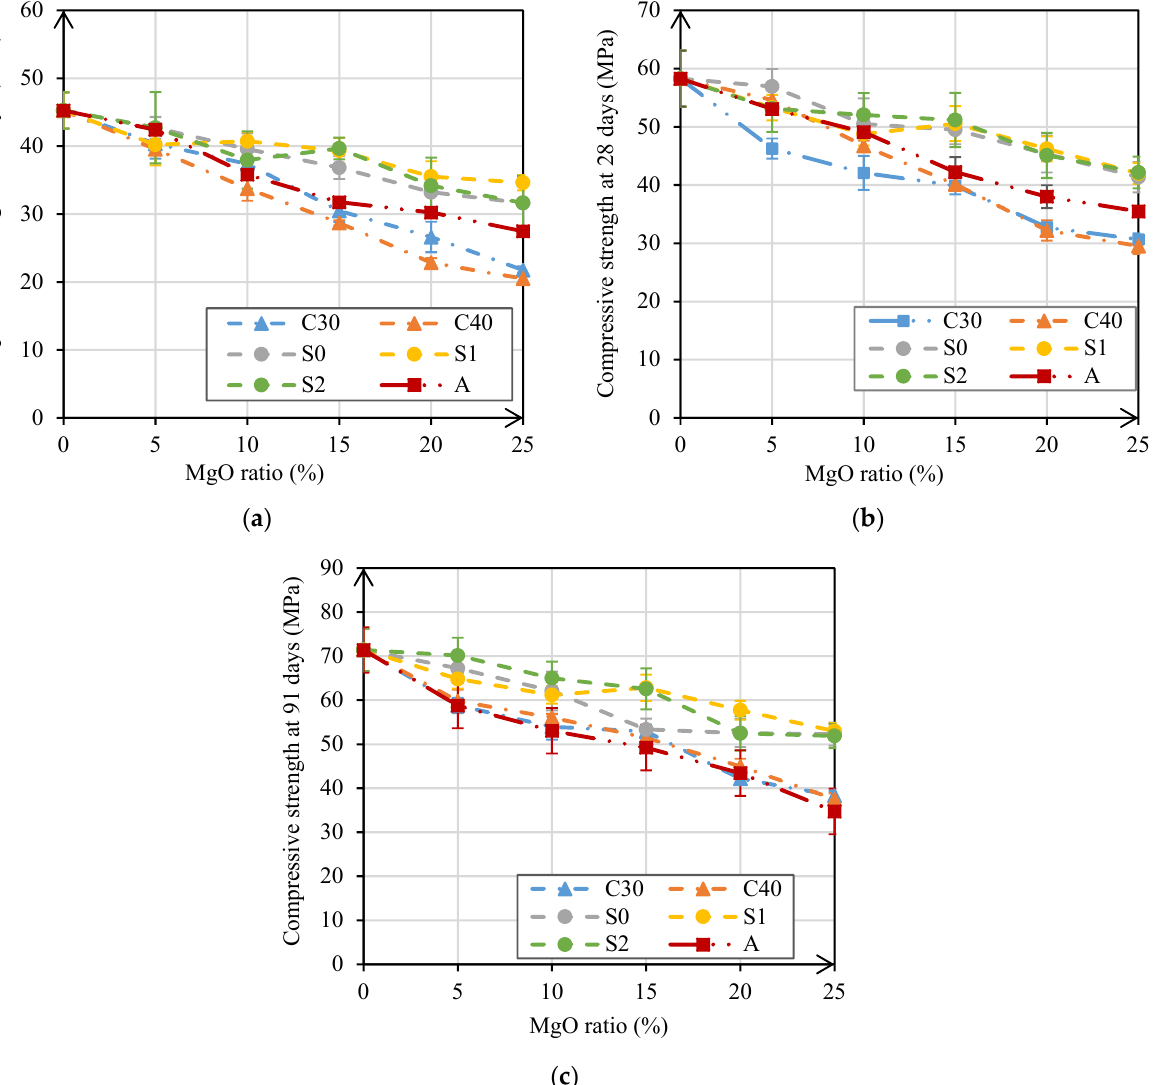
Figure 4. Compressive strength at 7 days ( a ); 28 days ( b ); and 91 days versus MgO content ( c ).